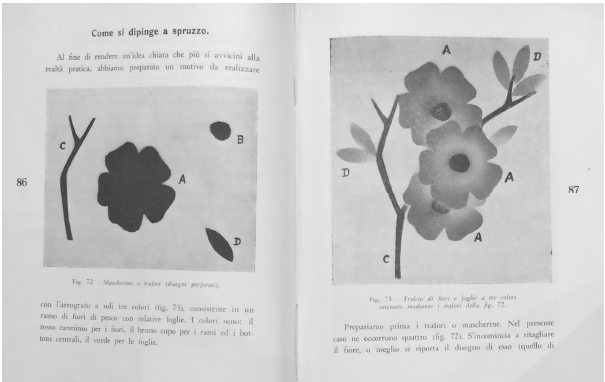
Figure 3. Instructions for spray painting from a 1936 manual for ceramic decoration (Ettorre 1936, pp. 86–87). In public domain.